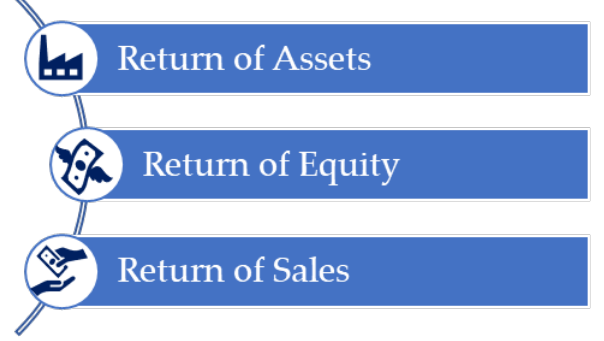
Figure 4 indicates the profitability indicators that were calculated.